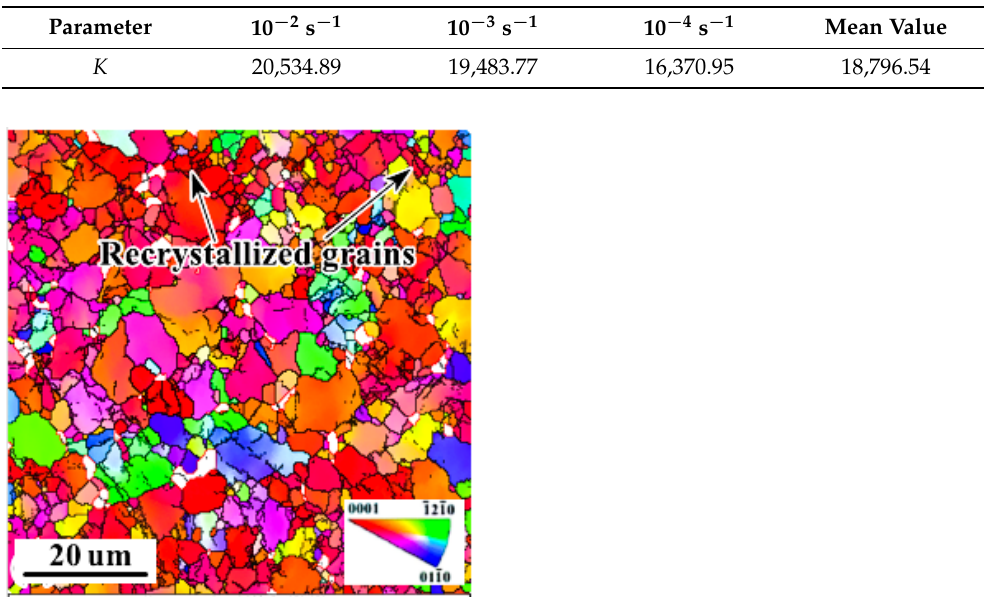
Figure 8. Relationship between ln [ sinh ( ασ )] and 1/T. Table 6. Determination results for K .